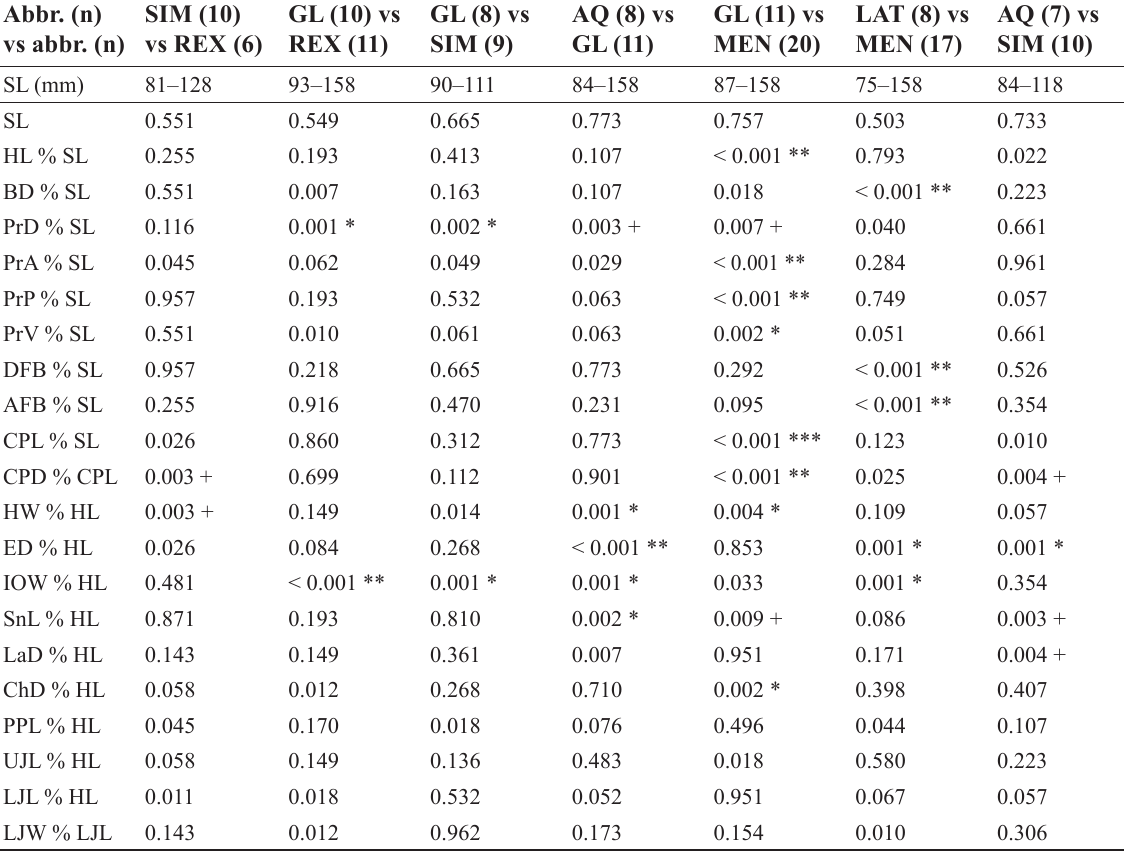
Table S8. (continued on the next three pages) Inter-species pairwise comparisons of the species of Haplochromis from the Lake Edward system with a piscivorous morphology by means of Mann-Whitney U tests. Each pairwise test was performed on subsets of specimens of a similar length class [MW U (SL): P > 0.5]. Sequential Bonferroni corrections for multiple tests were performed on each inter-species pair separately for measurements and counts separately. Raw p-values are shown and significance after sequential Bonferroni correction